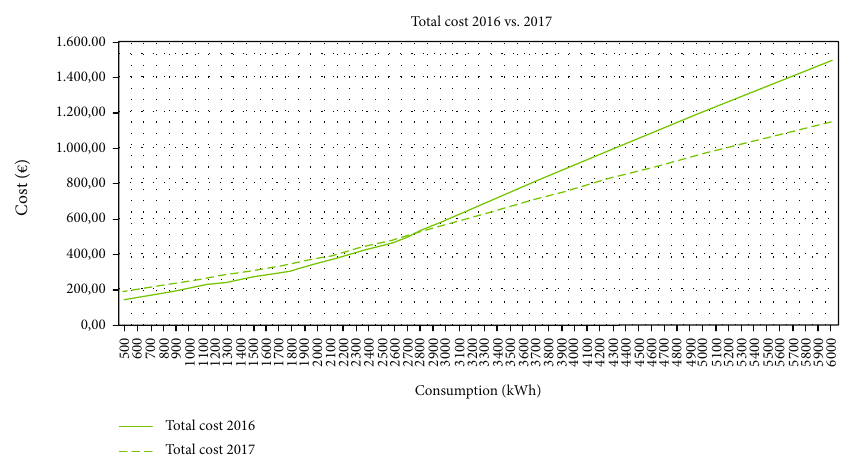
Figure 3: Annual electricity bill cost